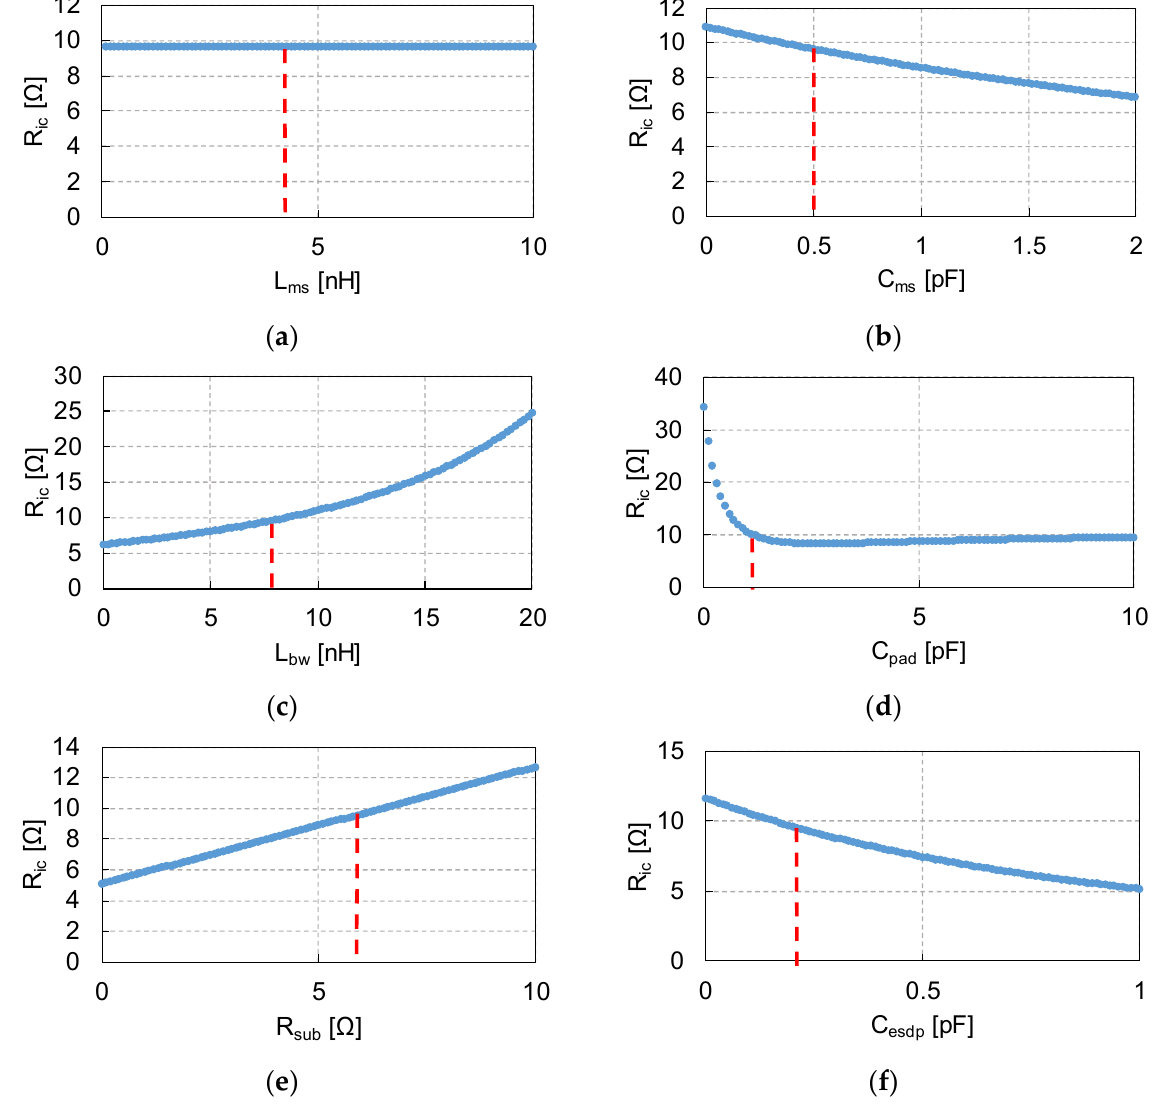
Figure 23.   as a function of each circuit parameter: ( a )   sweep, ( b )   sweep, ( c )   Figure 23. R ic as a function of each circuit parameter: ( a ) L ms sweep, ( b ) C ms sweep, ( c ) L bw sweep, sweep, ( d )   sweep, ( e )   sweep, ( f )   sweep. ( d ) C pad sweep, ( e ) R sub sweep, ( f ) C esdp